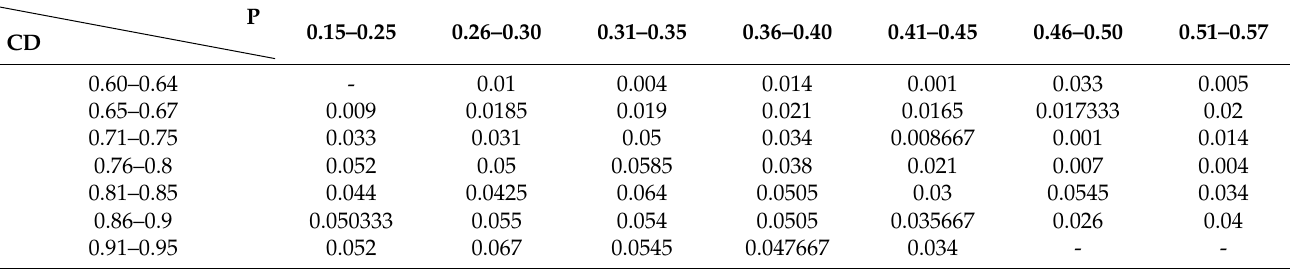
Table 5. Mean values of regression model of canopy density, porosity, and humidifying